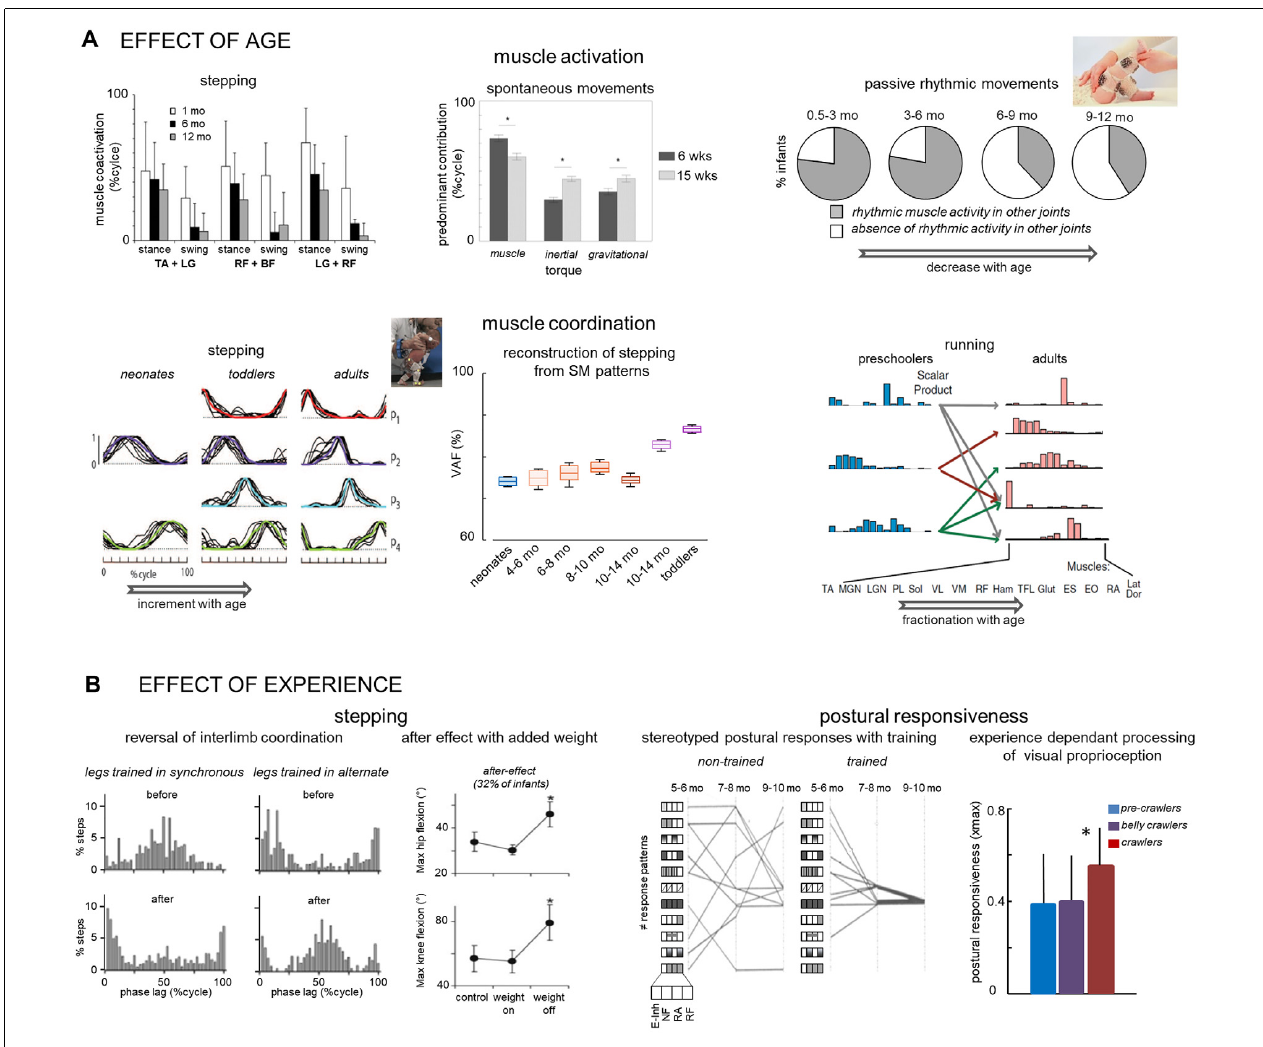
FIGURE 2 | Early development of locomotor-related movements: effect of age (A) and experience (B) . (A) Upper panels —age-related changes in muscle activation (from left to right): reduction of agonist-antagonist co-activation (adapted from Teulier et al., 2012); change in the differential cofntribution of distinct components (muscle, inertial, or gravitational) of the net knee torque during SMs (adapted from Sargent et al., 2015); reduction of muscle responses in other joints (not being rotated) during passive rhythmic movements (adapted from Solopova et al., 2019). (A) Lower panels —age-related changes in muscle coordination (from left to right): increase of the number of basic muscles activation patterns (adapted from Dominici et al., 2011); reconstruction of stepping muscle activity from basic activation patterns of neonate SMs increases with age (adapted from Sylos-Labini et al., 2020); fractionation of preschoolers muscle synergies of running to become multiple synergies in adults (with no running experience; adapted from Cheung et al., 2020). (B) Experience-dependant stepping (left two panels) and postural (right two panels) responses in infants. Left panel —the reversal of interlimb coordination in two groups of infants initially displaying distinct leg coordination (stepping and hopping) after 4 weeks of reversed leg coordination training (adapted from Musselman and Yang, 2008). Second panel —occurrence of aftereffects (changes in the hip and knee flexion during the swing) following removal of an additional weight on the ankle (adapted from Lam et al., 2003). Third panel —development of stereotyped response patterns (block diagrams on the left indicate different initial response patterns) during slow forward surface translations in trained infants (adapted from Hadders-Algra et al., 1997). Right panel —postural responsiveness to whole-room forward movement is greater in crawlers who experienced optic flow, in comparison to pre-crawlers and belly crawlers who did not experience it. Responsiveness was evaluated as the max cross-correlation (xmax) between the wall movement and the infant’s postural sway (adapted from Anderson et al., 2019). The * indicate significant